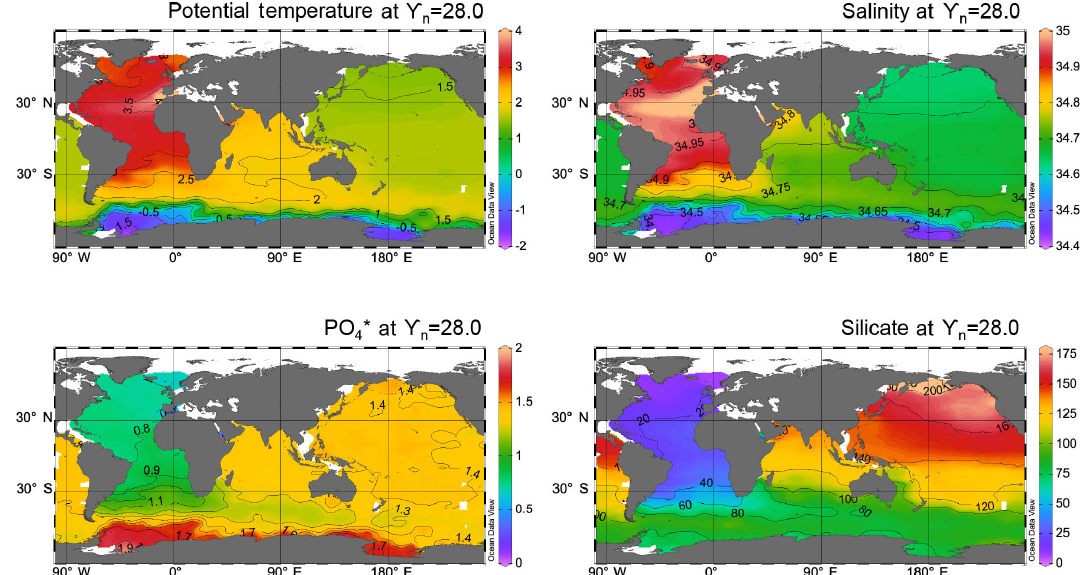
Figure A5. Potential temperature, salinity, PO ∗ , and silicate on the 28.0 isopycnal horizon. The depth of this horizon is shown in Fig. 8 and 4 averages ∼ 2500m in the basins and ∼ 250m in the mixed layer in the Southern Ocean. Data are from GLODAPv2 (Key et al., 2015; Olsen et al., 2016) with profiles, maps, and sections plotted in ODV (Schlitzer,